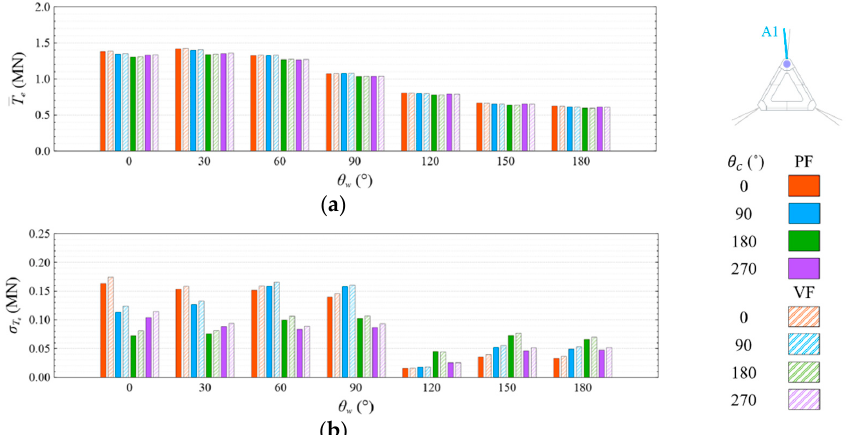
Figure 34. Comparison of ( a ) means and ( b ) standard deviations of mooring line tension of Line A1 under HW condition.